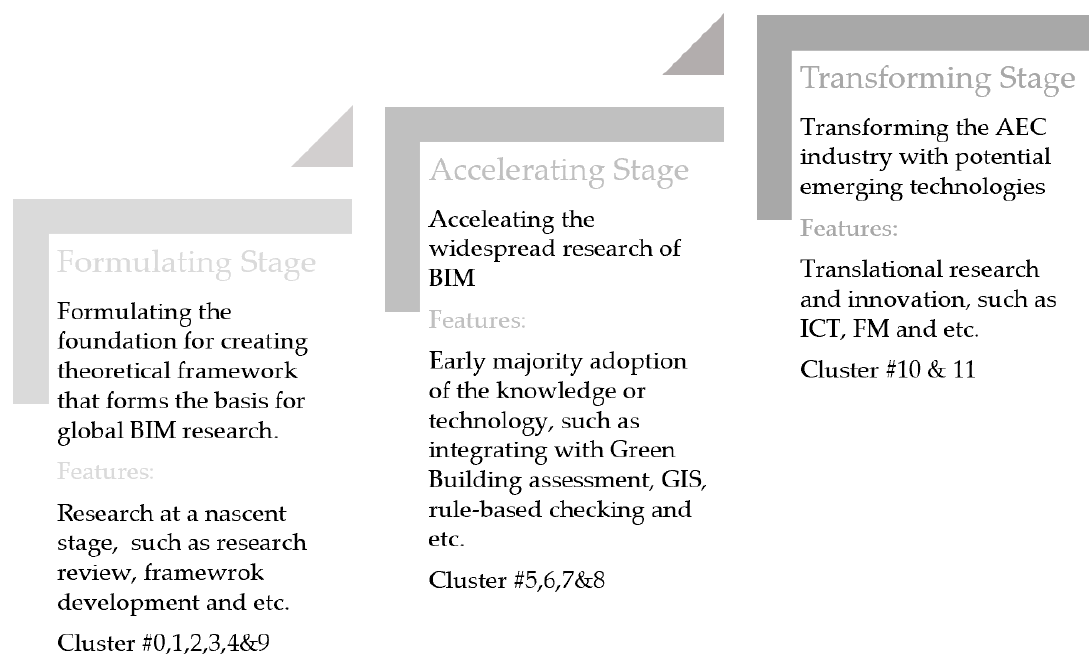
Figure 14. Evolution of global BIM research.